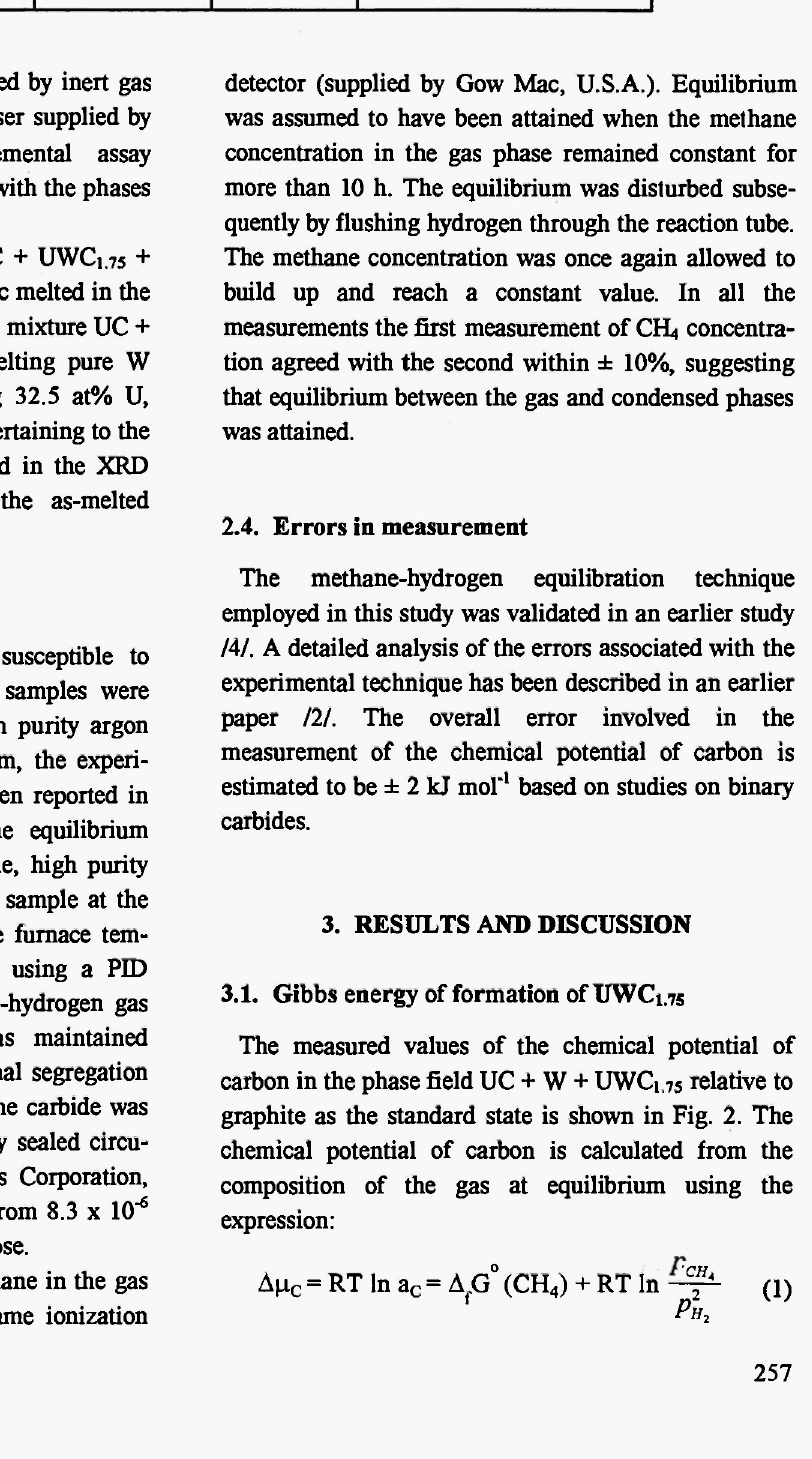
Phases identified in